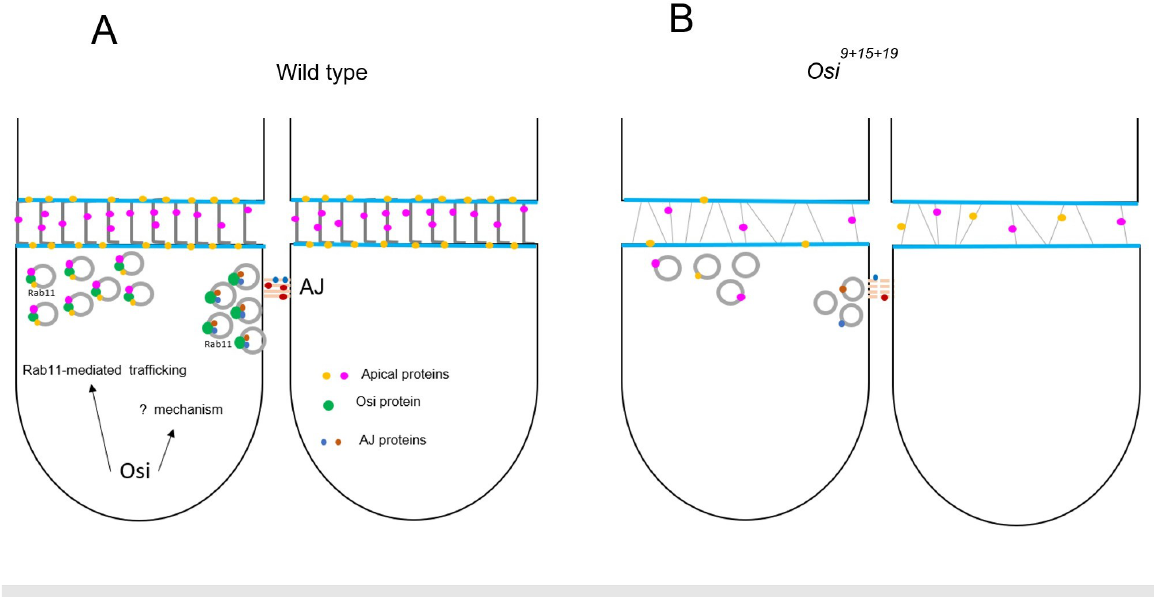
Fig 9. Model of the function of Osi genes in the Drosophila trachea. Osi genes potentially regulate tube maturation through Rab11-mediated trafficking. (A) In wild-type control, Osi proteins are hypothetically involved in sorting cargos to Rab11-containing recycling endosomes and/or in transporting cargos apically to sustain AJs and to form taenidial folds. After apical delivery, Osi proteins could be recycled back to carry out their functions again. (B) In Osi mutants, these cargos are not sorted and transported efficiently, which leads to reduced apical delivery of cargos required for tube maturation. It is also possible that Osi genes regulate a currently unknown mechanism that converges or acts in parallel with Rab11-mediated trafficking in wild type trachea (A). Green-filled circles are Osi proteins, grey circles are Rab11-containing recycling endosomes. Filled pink and orange circles are cargo proteins delivered to the apical membrane/aECM. Filled blue and dark brown circles are cargo proteins delivered to AJs. Blue lines are apical membranes, and gray lines between apical membranes are taenidial folds. Solid and dotted light brown lines are AJs in wild type and Osi mutants